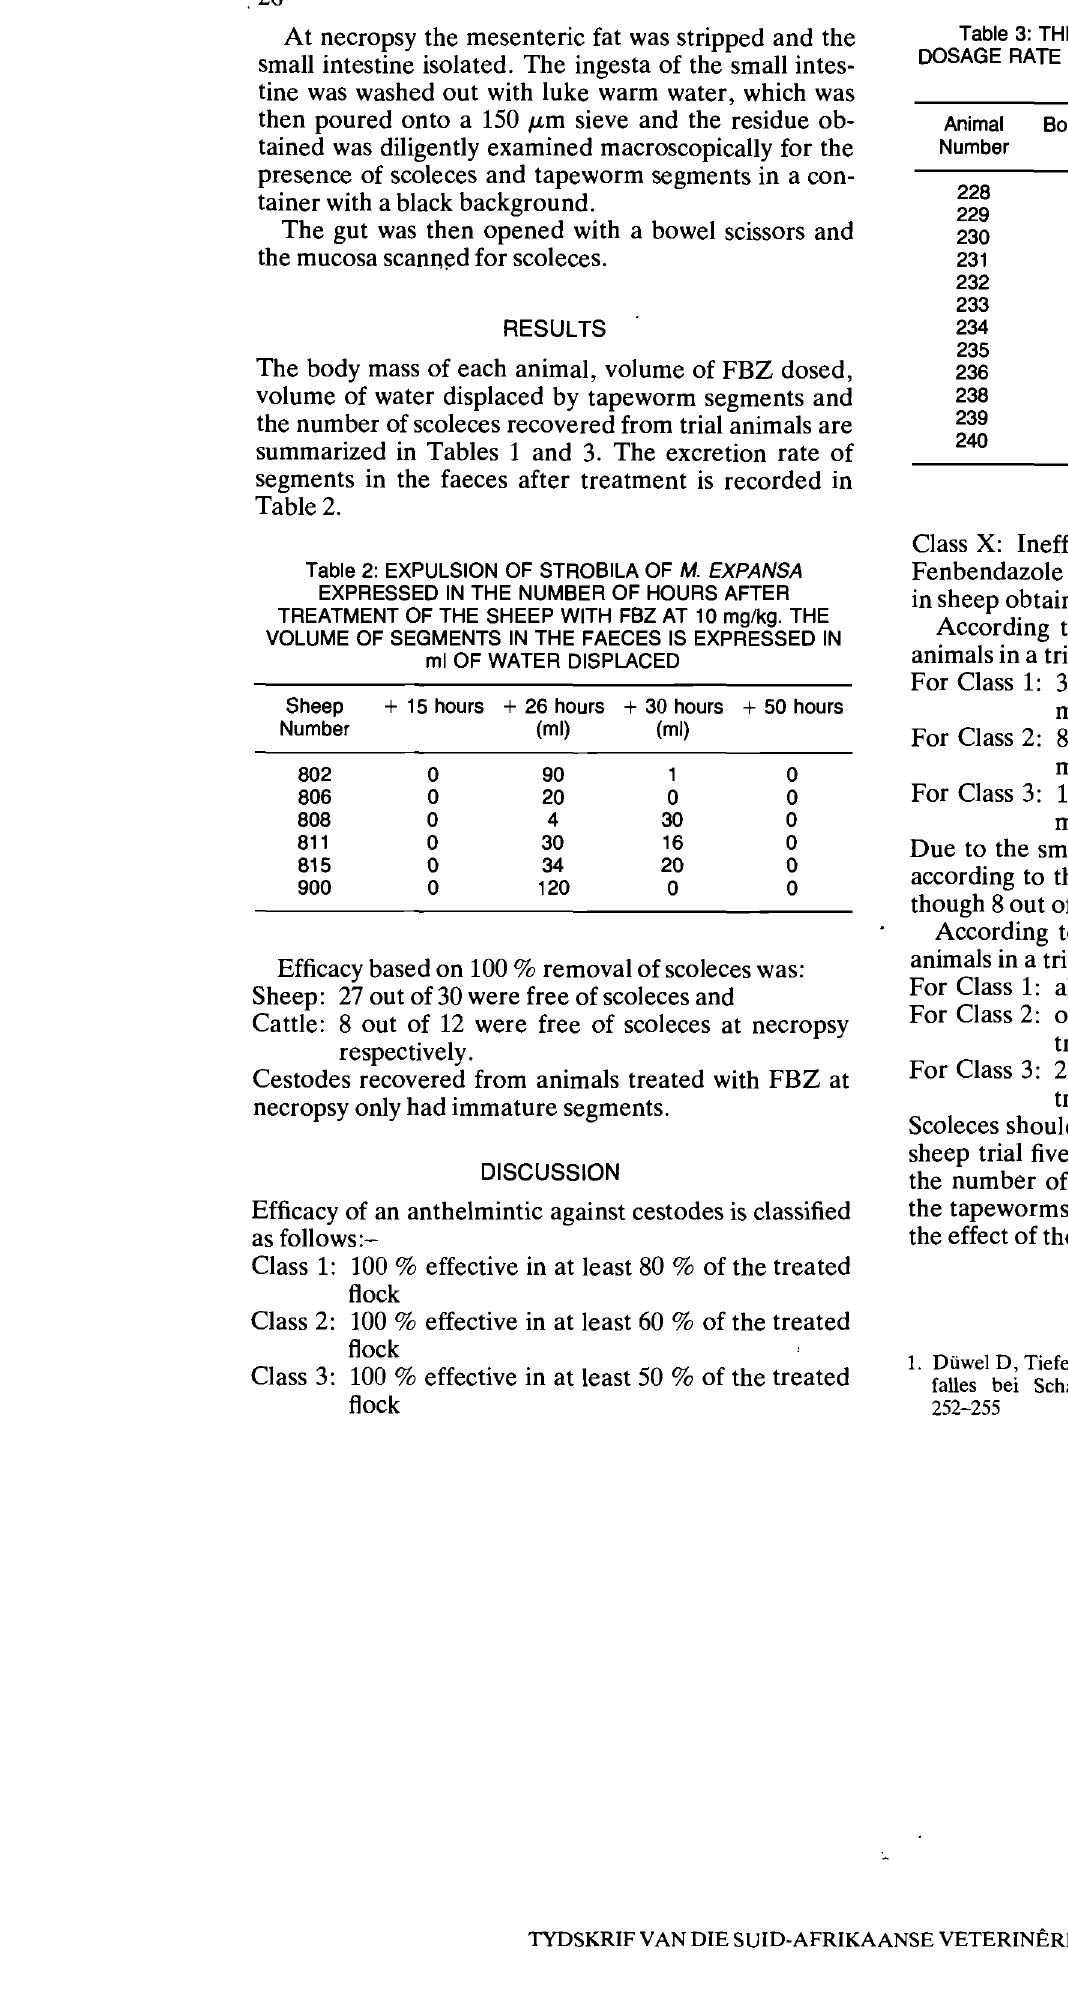
Table 2: EXPULSION OF STROBILA OF M. EXPANSA EXPRESSED IN THE NUMBER OF HOURS AFTER TREATMENT OF THE SHEEP WITH FBZ AT 10 mg/kg. THE VOLUME OF SEGMENTS IN THE FAECES IS EXPRESSED IN ml OF WATER DISPLACED